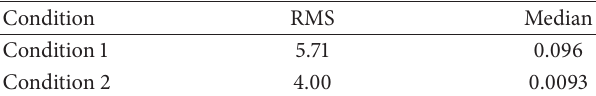
Table 1: Statistical characterization of the vibroacoustic